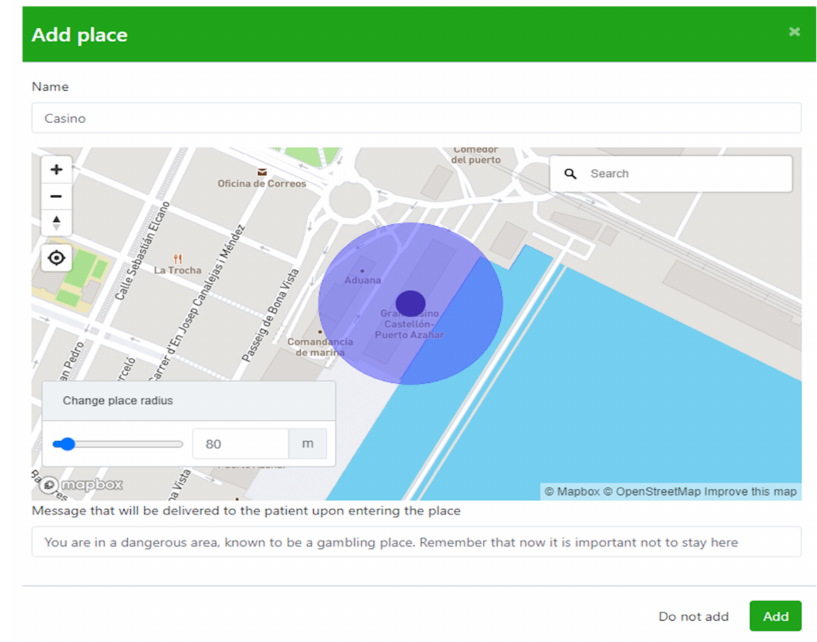
Figure 1. Smartphone app configuration during the SC therapeutic component.